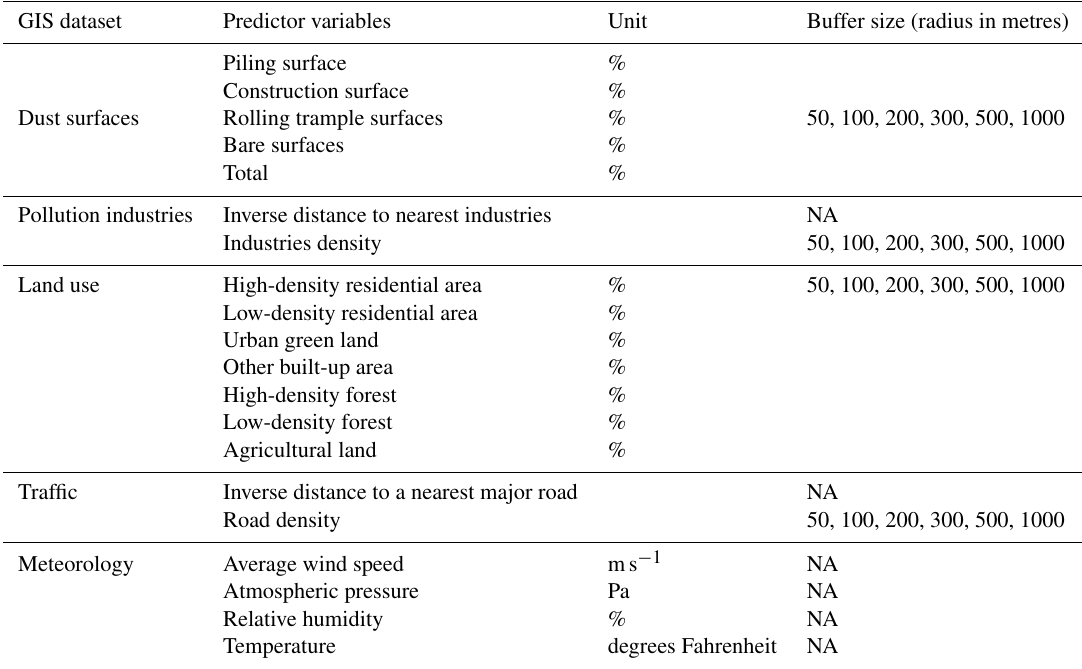
Table 2. Description of potential predictor variables for LUR. NA – not available. GIS dataset